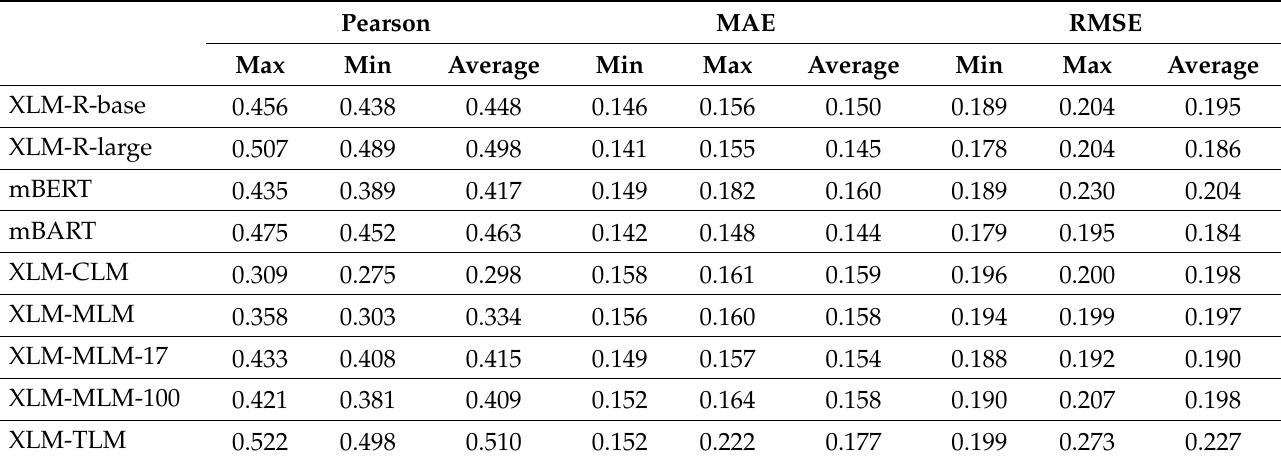
Table 3. mPLM finetuning results for the test set of the WMT20 sub-task 2. Pearson MAE